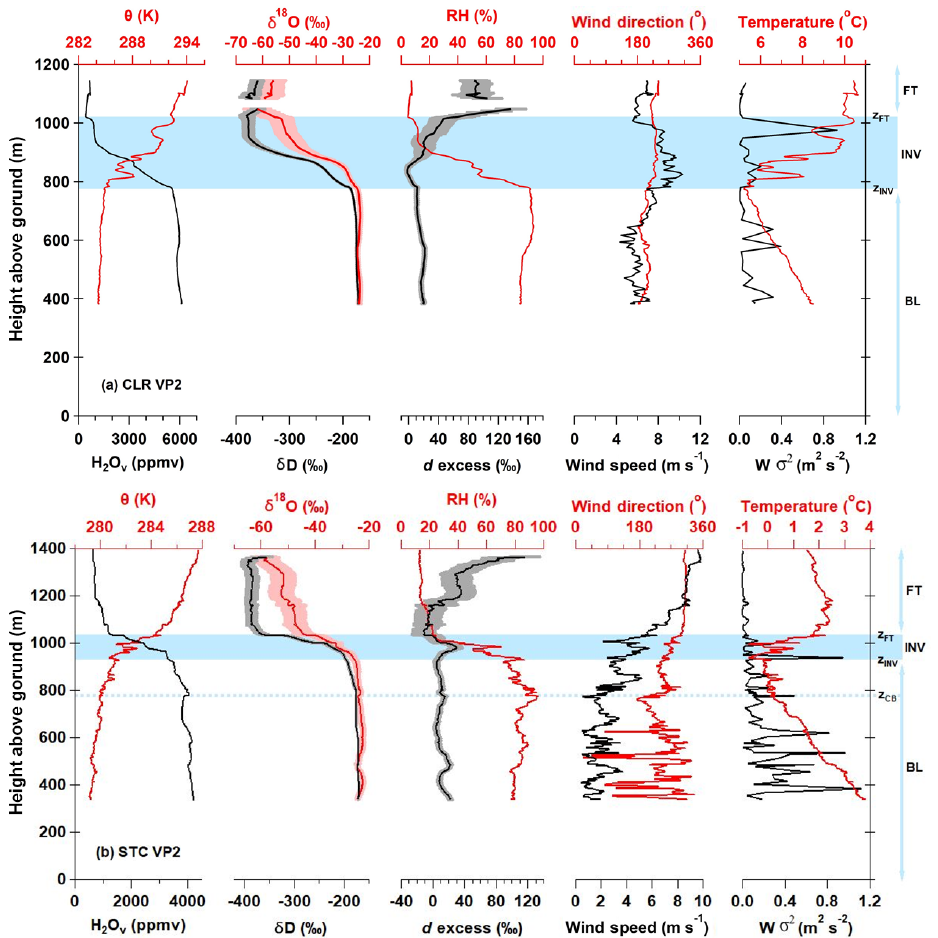
Figure 6. Observations of meteorological and isotope variables along the second VP (VP2) conducted on (a) CLR (MAR06) and (b) STC (MAR04). Shading around the δ 18 O, δ D, and d -excess VP measurements defines measurement uncertainty. Altitudes of the boundary layer (BL), inversion layer (INV), and free troposphere (FT) are indicated for reference. The inversion layers, which are bound at the bottom and top by z INV and z FT , respectively, are identified by blue horizontal bands. The dashed blue line in (b) corresponds to stratocumulus cloud base ( z CB